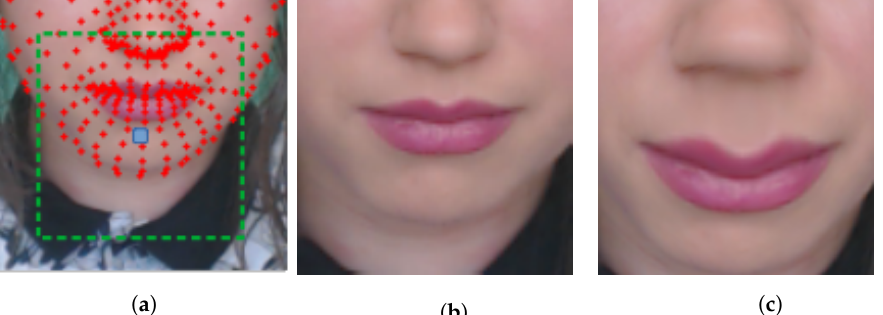
Figure 3. Exemplification of the construction of ROIs. ( a ) Example of the center point C of an ROI. ( b ) Example of the ROI cutout of the mouth without distortion. ( c ) Example of an ROI cutout of a mouth with